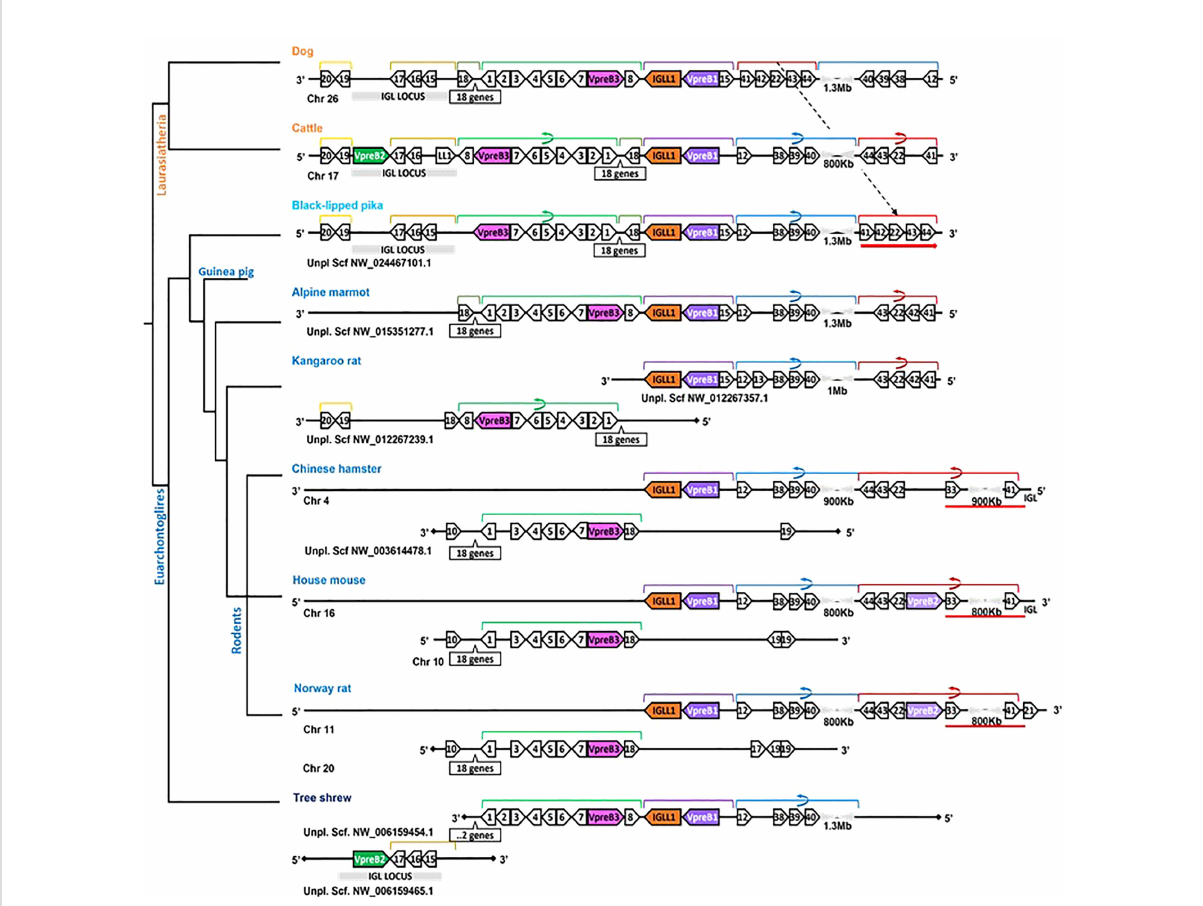
FIGURE 5 Locus synteny of VpreB3 and surrogate light chain (VpreB1, VpreB2, IGLL1) genes in Glires (rabbits and rodents) and their closest relatives. Genes are shown in pink (VpreB3), purple (VpreB1), green (VpreB2), and orange (IGLL1). Polygons containing syntenic genes found in two or more species contain a number corresponding to the gene name (see Figure 3 for gene names represented by each numbered polygon). Polygons containing genes for uncharacterized proteins are empty. A solid line represents contiguous genomic sequence (chromosome or unplaced scaffold) and is denoted by the chromosome (Chr) or scaffold (Scf) to which it belongs. A line ending in a diamond shape indicates the end of a chromosome or scaffold and no further genes occur in that direction. Orientation of chromosomes or scaffolds is indicated by the 5 ’ or 3 ’ labels at the ends of the solid lines, and gene polygons point in their transcriptional direction. Colored lines above the polygons denote syntenic gene blocks, and lines containing an arrow indicate the syntenic block is inverted compared to dog. A red line below the polygons indicates an insertion of non-syntenic genes that includes this second VpreB gene in Glires. The location of the lambda light chain locus (IGL, if present) is indicated by a gray rectangle. Orthologs between species are aligned vertically, but distances are not to scale. A model cladogram is provided for reference. Tree topology is informed by published phylogenies (35 – 38). Created with